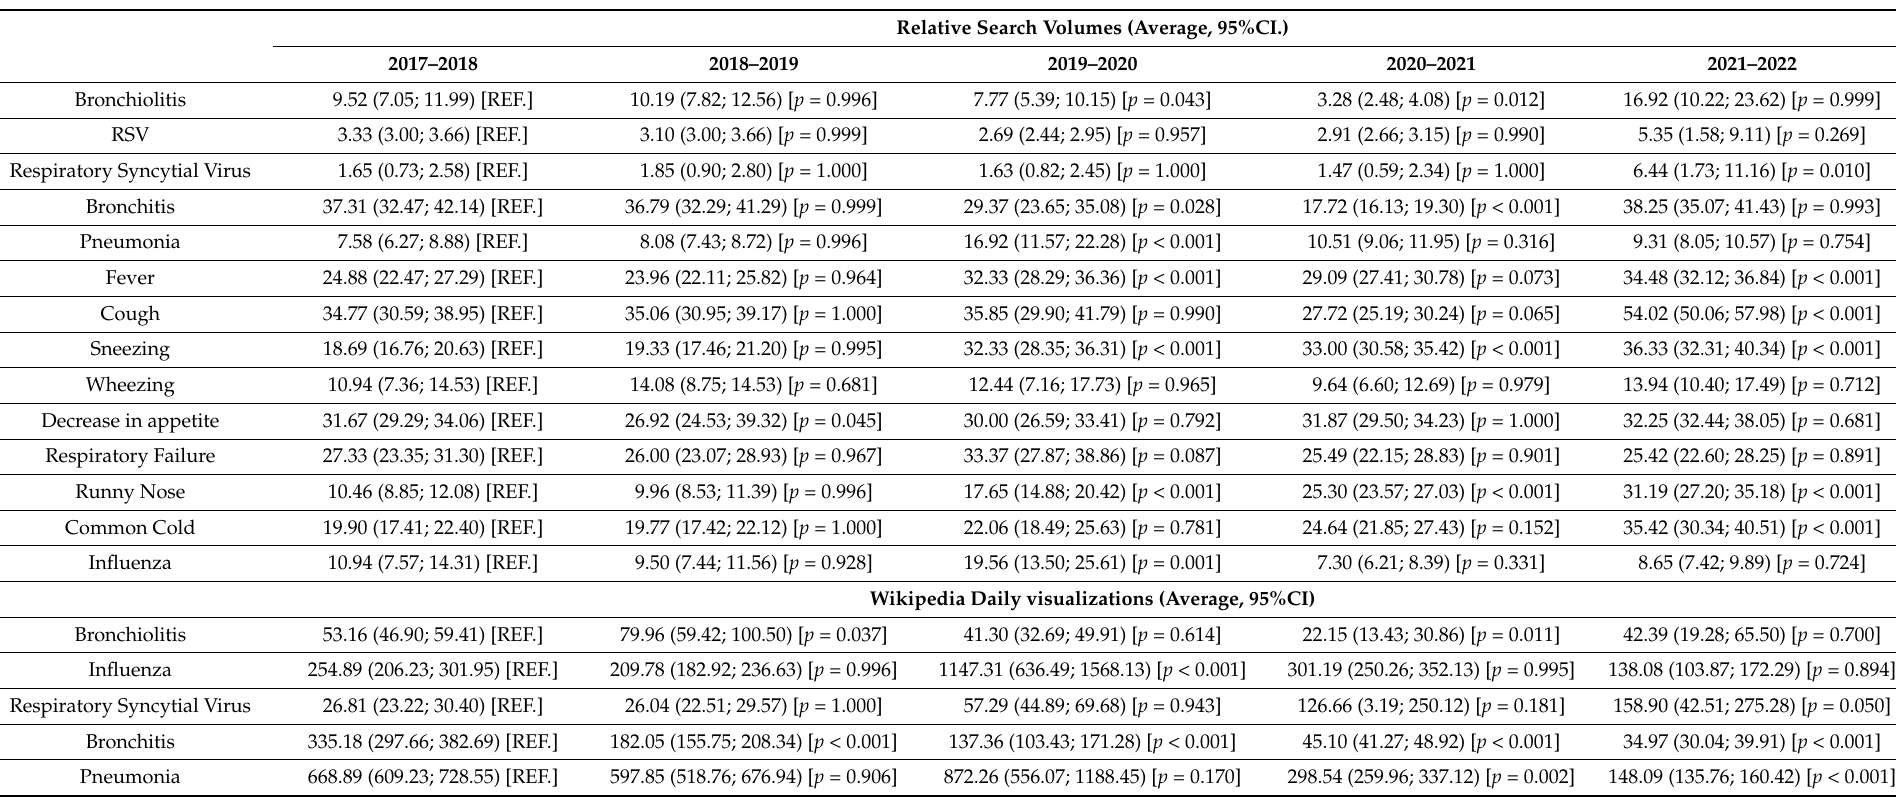
Table 4. Relative search volumes for the assessed research terms, average and correspondent 95% confidence intervals (95%CI). Comparisons were performed by mean of Analysis of the Variance (ANOVA) with Dunnet’s post hoc test (reference category [REF]: reporting season 2017–2018). Relative Search Volumes (Average,